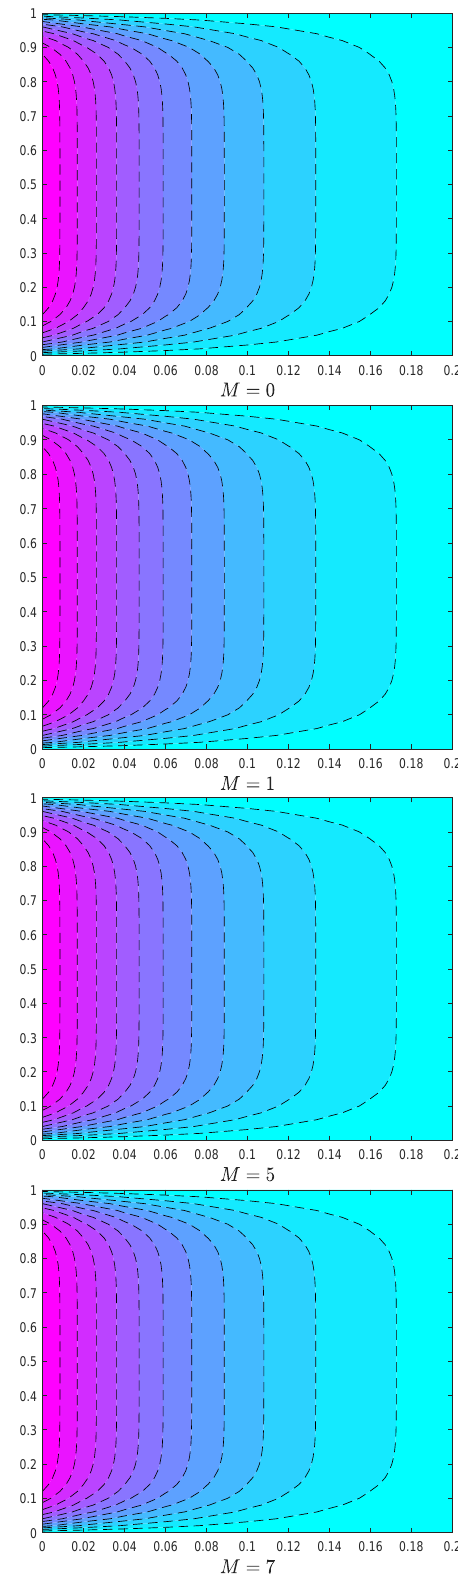
Figure 7. Temperature profile for different values of magnetic parameter M